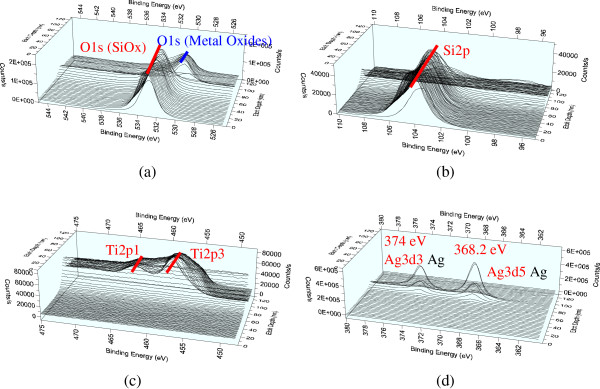
XPS analysis of the bonds. (a) The oxide bond. (b) The Si-O bond of SiO2. (c) The Ti-O bond of TiO2. (d) The Ag-Ag bond.